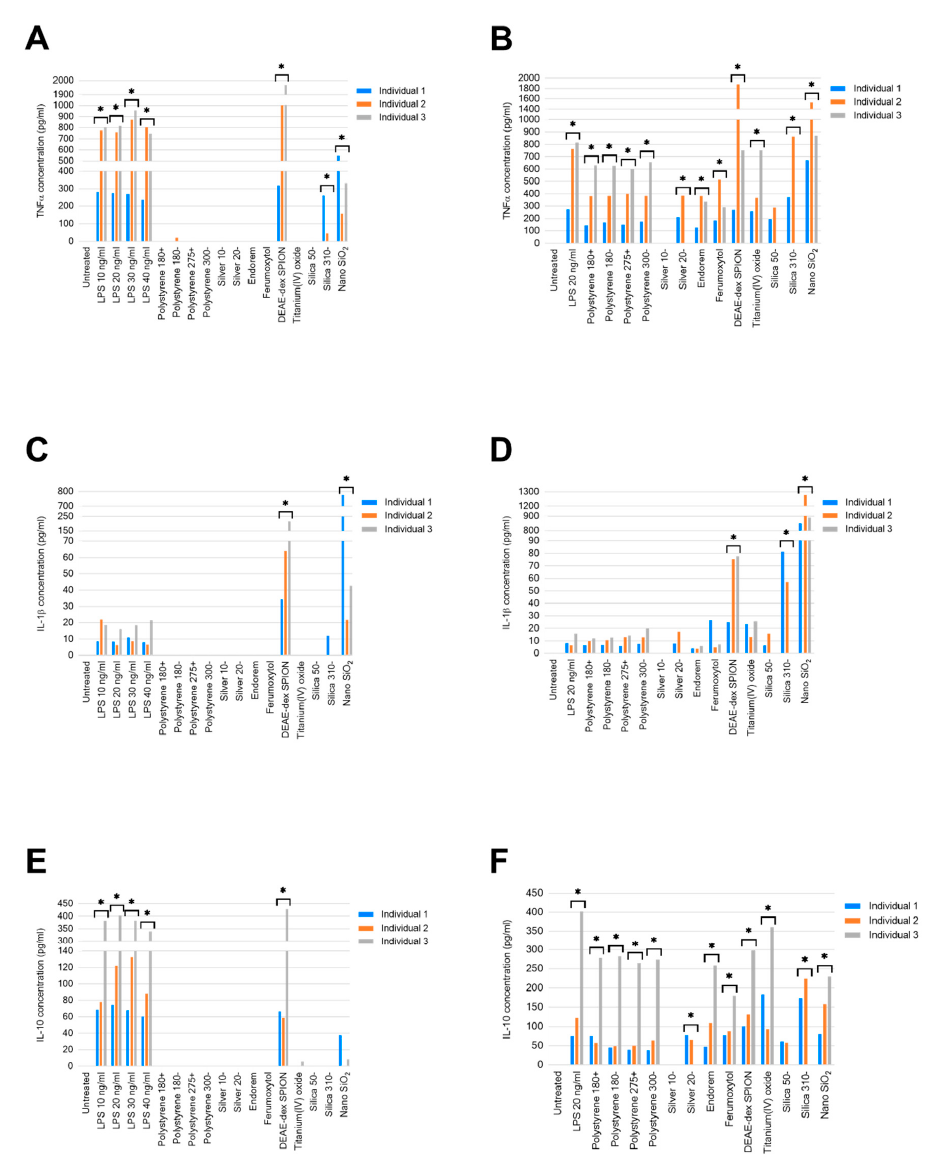
Figure 1. Concentrations of stated cytokines secreted by peripheral blood mononuclear cells